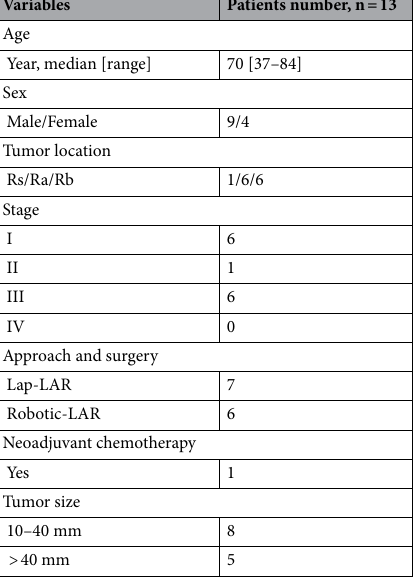
Table 1. Clinical features of the patients. Lap- laparoscopic assisted, LAR lower anterior resection.